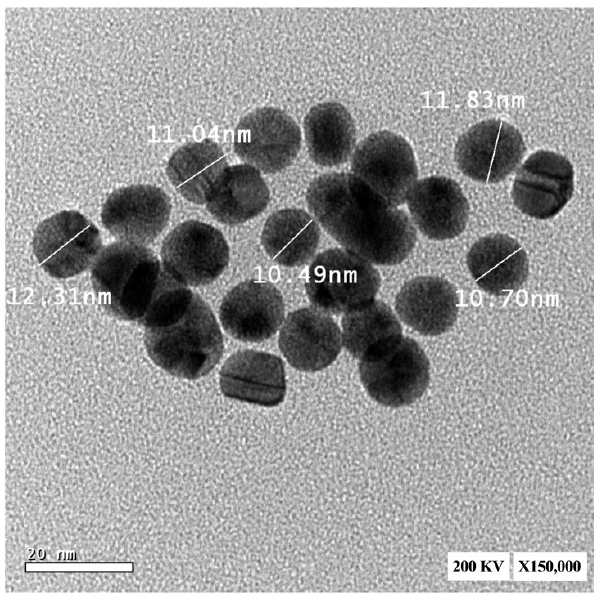
Figure 6. Transmission electron microscopic image of AuNPs.